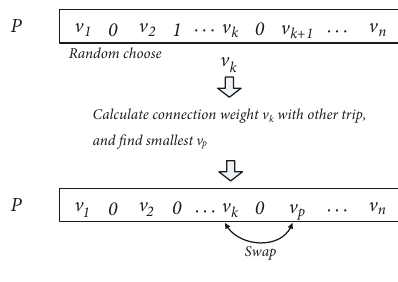
Figure 5: Mutation procedure.